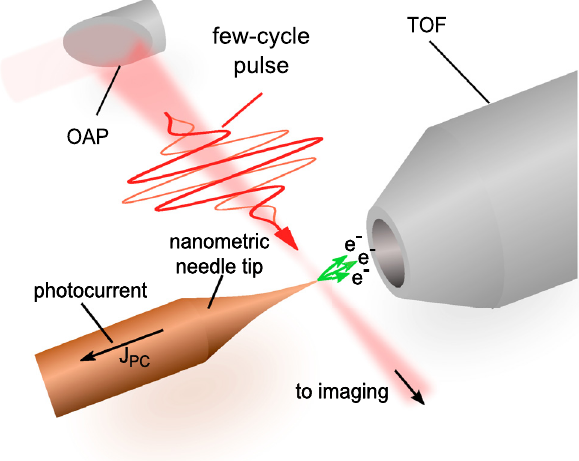
Figure 1: Experimental setup: a linearly polarized few-cycle pulse at 750 nm with controlled CEP (thick red line showing a cosine pulse for CEP = 0, and thin red line showing a -cosine pulse for CEP = 𝜋 ) irradiates a tungsten nanometric needle tip. The CEP and dispersion are adjusted with fused silica wedges (not shown). In addition to the kinetic energy spectrum of emitted electrons measured using a TOF-spectrometer, the photocurrent from the tip is